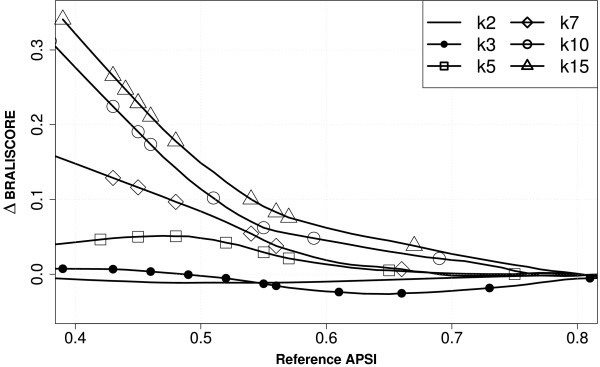
Performance of Prrn compared to ClustalW in dependence on sequence number per alignment. The plot shows the difference of the scores of PRRN as a representative of an iterative alignment approach and CLUSTALW (standard options) as a representative of a progressive approach.